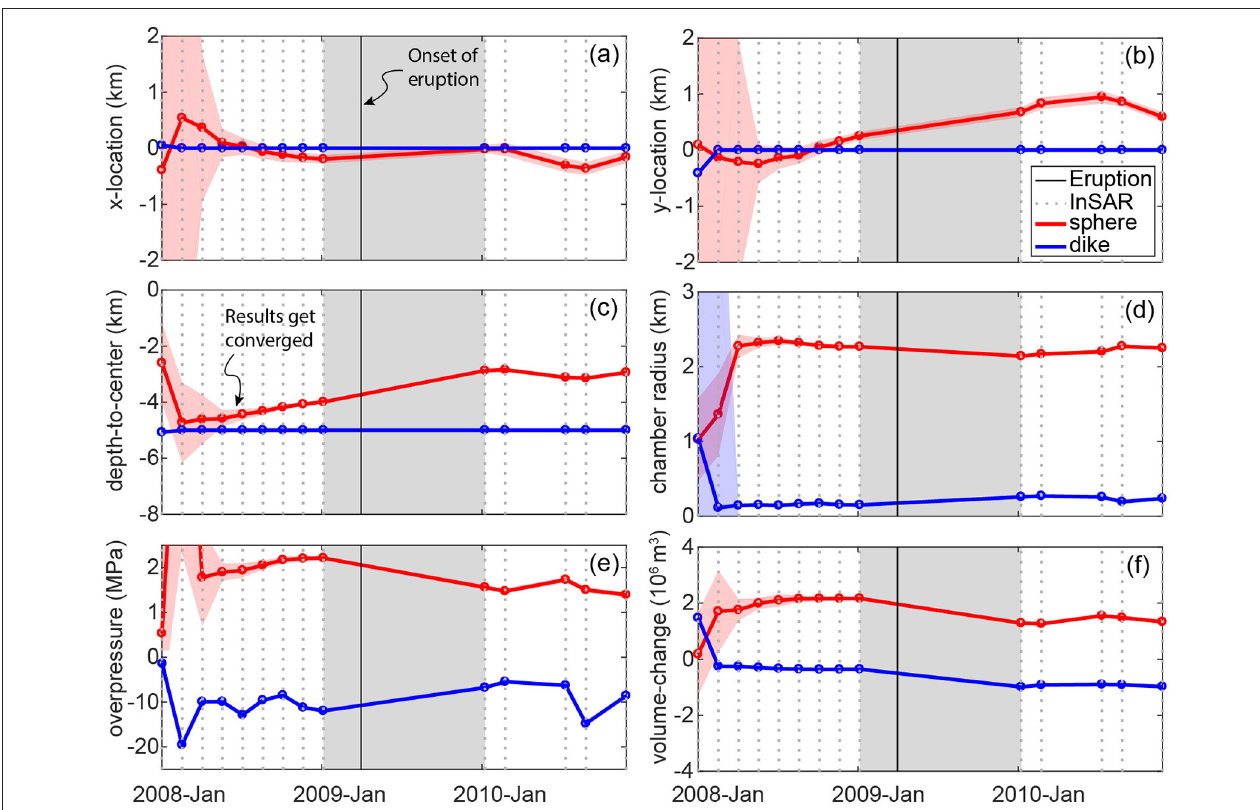
FIGURE 6 | EnKF parameter estimations for the spherical (red lines) and dike-shaped (blue lines) sources. The EnKF predictions start to converge after several three epochs of InSAR time series data are assimilated. The x- and y-location in (a) and (b) are the horizontal distances between the deformation sources and the center of the volcano. (c) Is the depth to the center of the source. (d,e,f) Are the radius, overpressure and volume change of the source. The colored solid lines and shaded areas indicate the ensemble means and standard deviations respectively. The colored circle symbols indicate the estimated parameters of the best-fit model from each ensemble at each time step. The black dashed lines indicate time steps when InSAR data were assimilated. Notice the upper and lower part of (e) have different scales of the